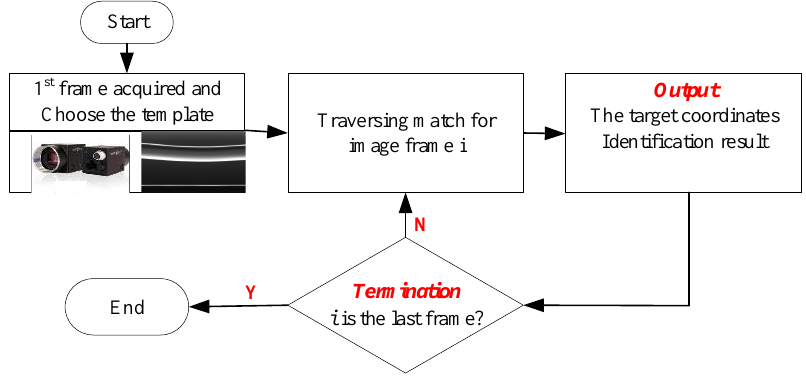
Figure 11. The framework of the proposed method for contact wire vibration measurement under different test conditions.